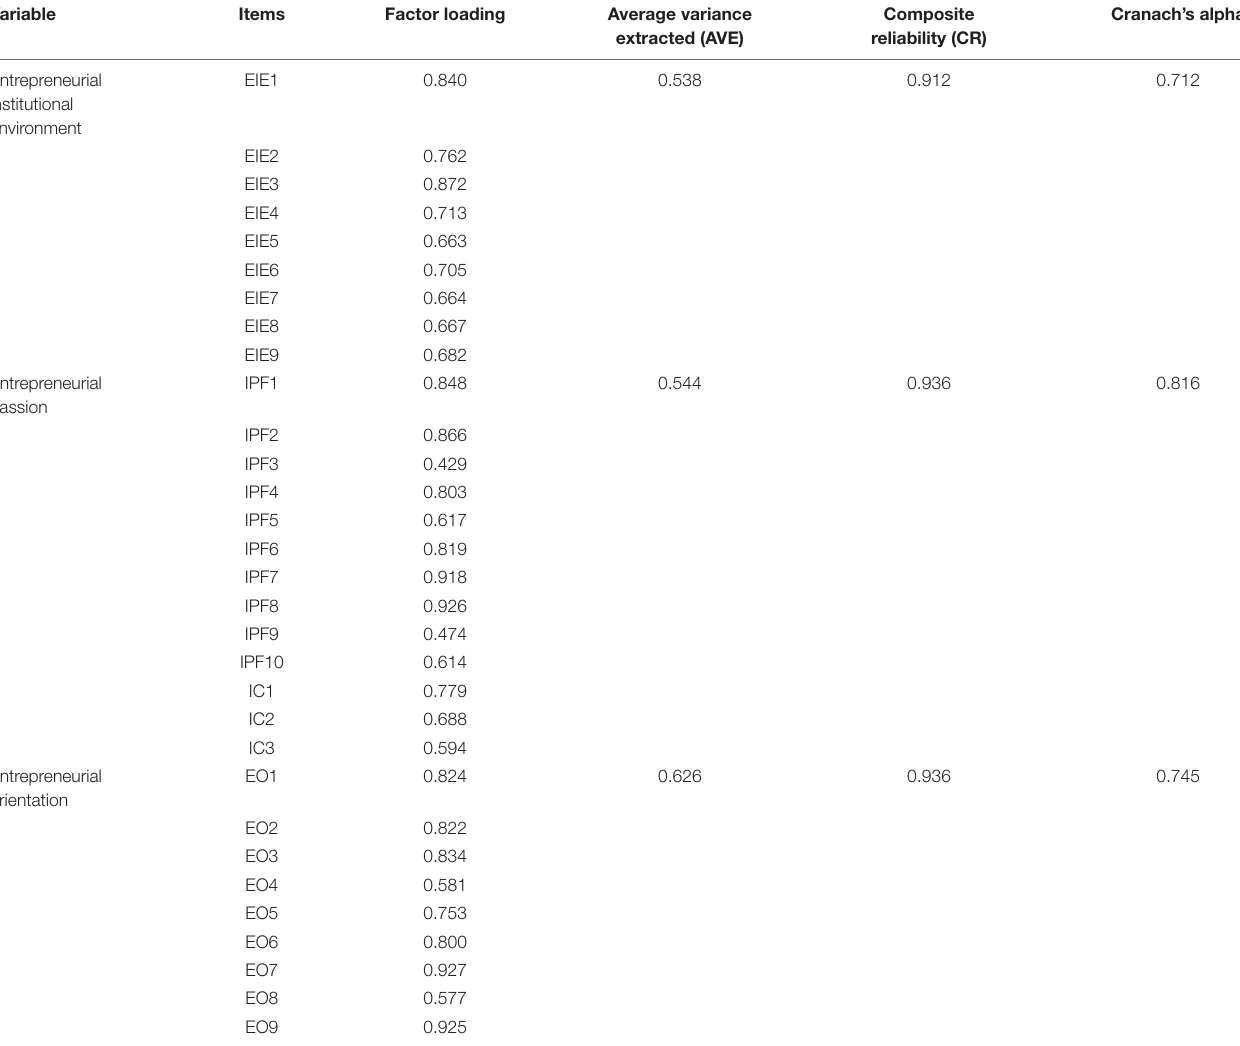
TABLE 2 | Indicators of measurement.